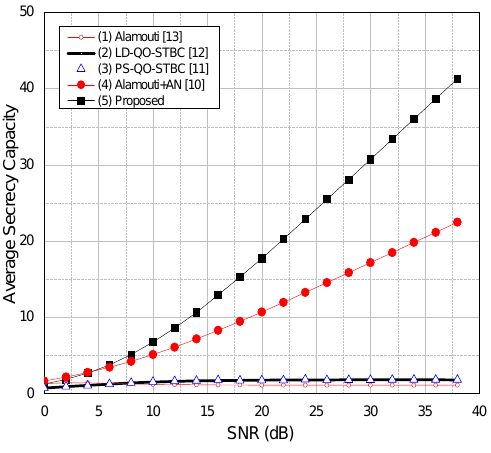
Figure 3. Secrecy capacity of the proposed scheme over a Rayleigh fading channel compared to the conventional space–time block coding (STBC)-based PLS